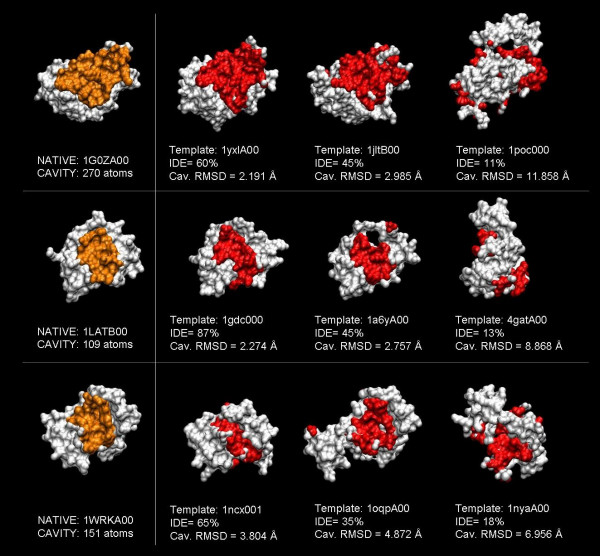
Examples of the relationship between rmsd and seq.id. For three cases (PDB codes: 1GOZ – S. aureus enterotoxin, 1LAT – R. norvegicus DNA binding domain of the glucocorticoid receptor, 1WRK – H. sapiens N-terminal domain of cardiac troponin C) we show how the quality of the largest cleft in the experimental structure decreases with seq.id. The atoms of the largest cleft in the experimental structures are shown in orange (structures in the left), while the same atoms are shown in red in the various homology models. Cleft quality becomes very poor at seq.id. below 30%, although even at higher seq.id. level some shape details are clearly lost. The distinct templates, as well as the target protein, are identified by their CATH [50] domain identifier, which comprises the four letters of the PDB code, a chain symbol, plus two digits indicating the domain.